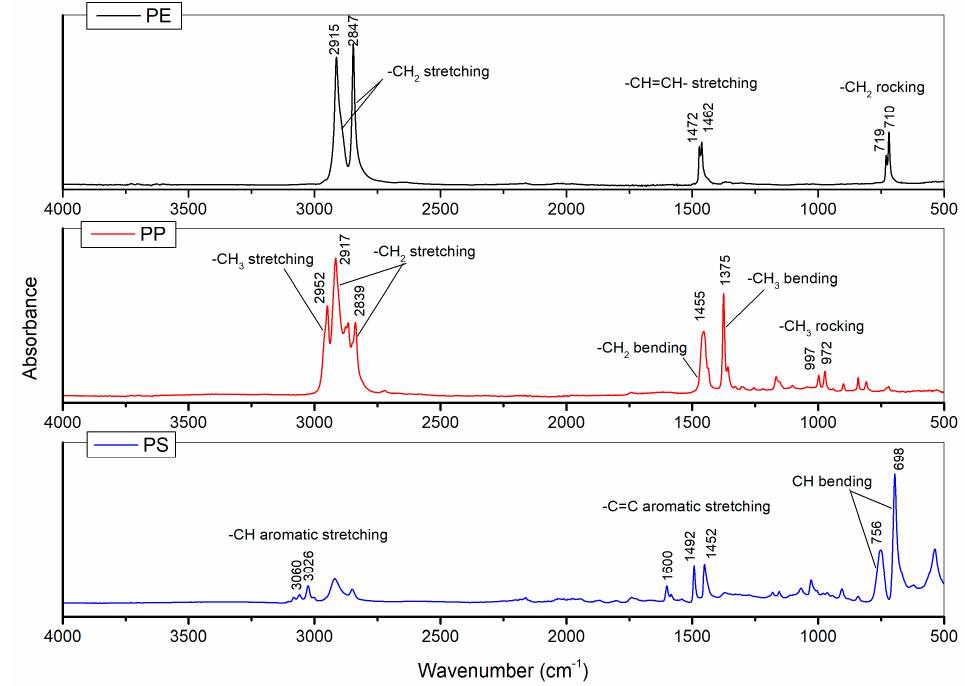
Figure 5. Comparison among the spectra of the PE natural weathered particles.